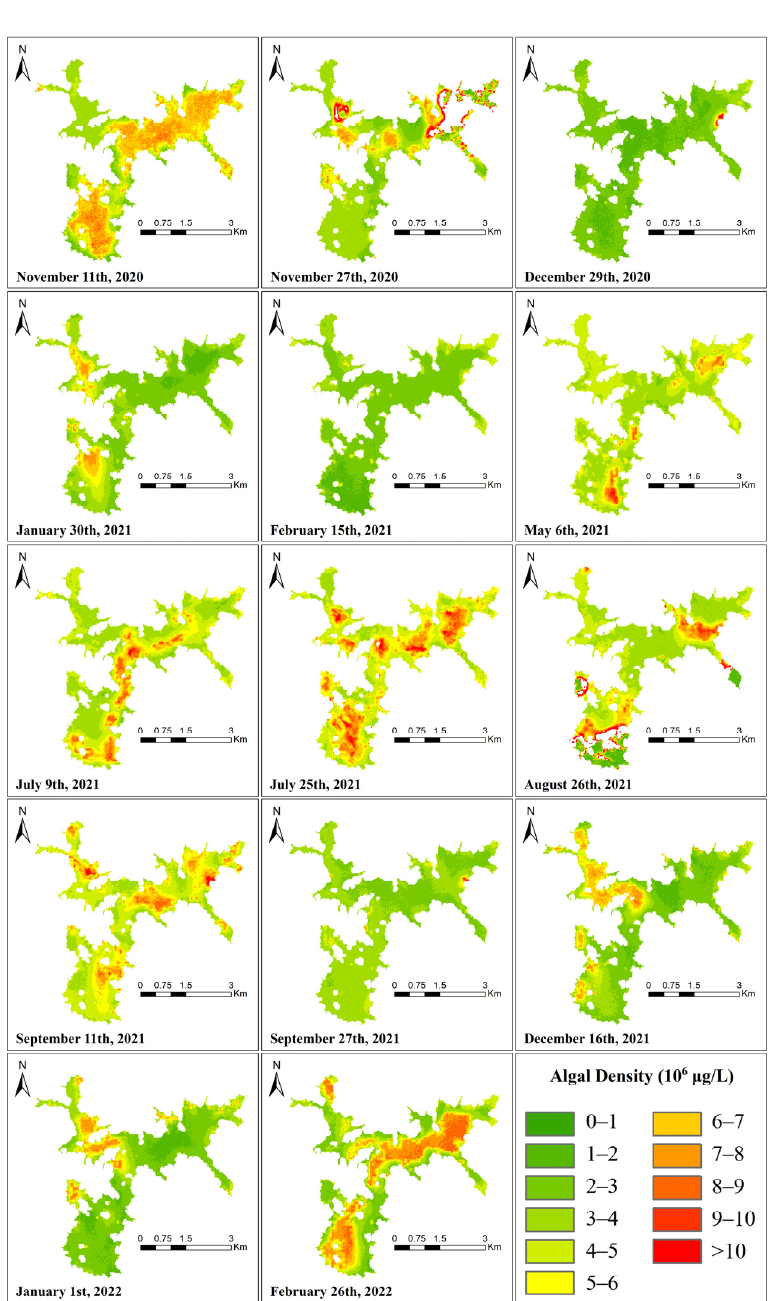
Figure 9. Spatial distribution of algal density concentration from Landsat OLI data.